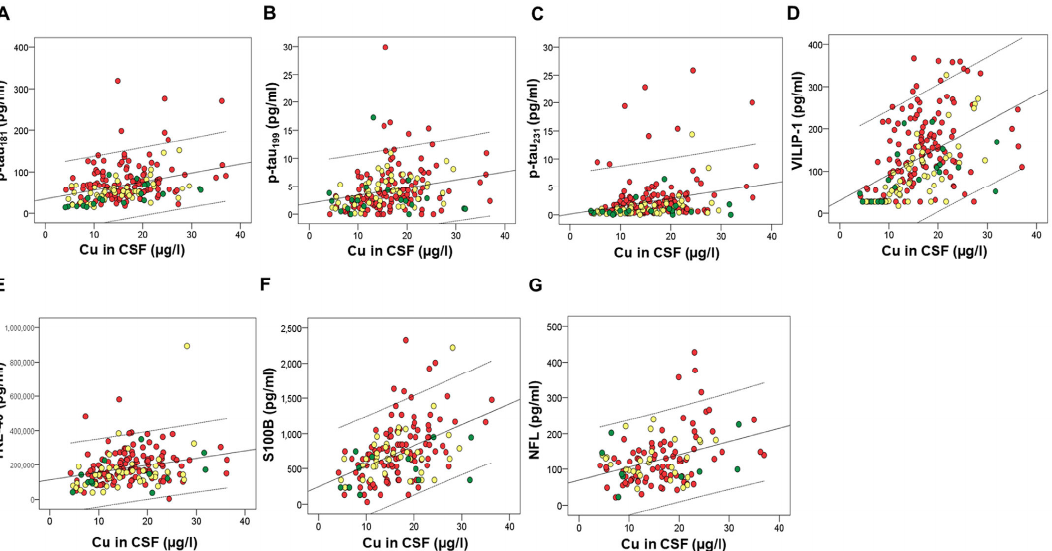
Figure 2. Correlation of CSF biomarkers VILIP ‐ 1 ( A ), S100B ( B ), and NFL ( C ) of AD with Zn meas ‐ ured in CSF. Red circles represent AD patients, yellow circles represent MCI patients, while green circles represent healthy controls.